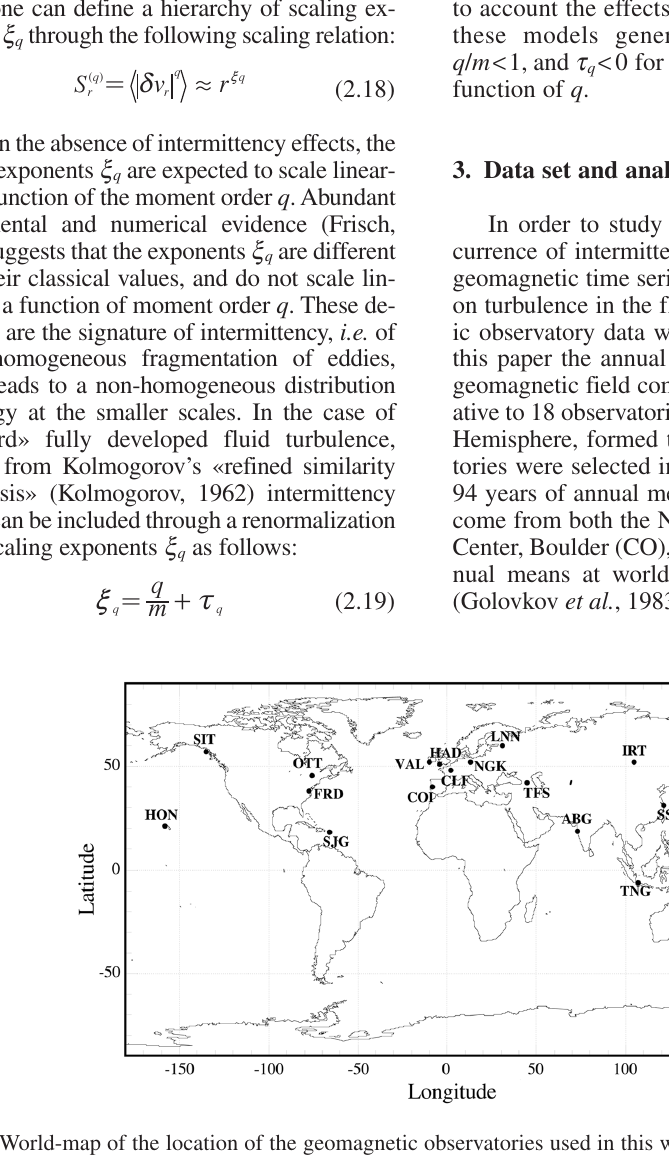
Fig. 1. World-map of the location of the geomagnetic observatories used in this